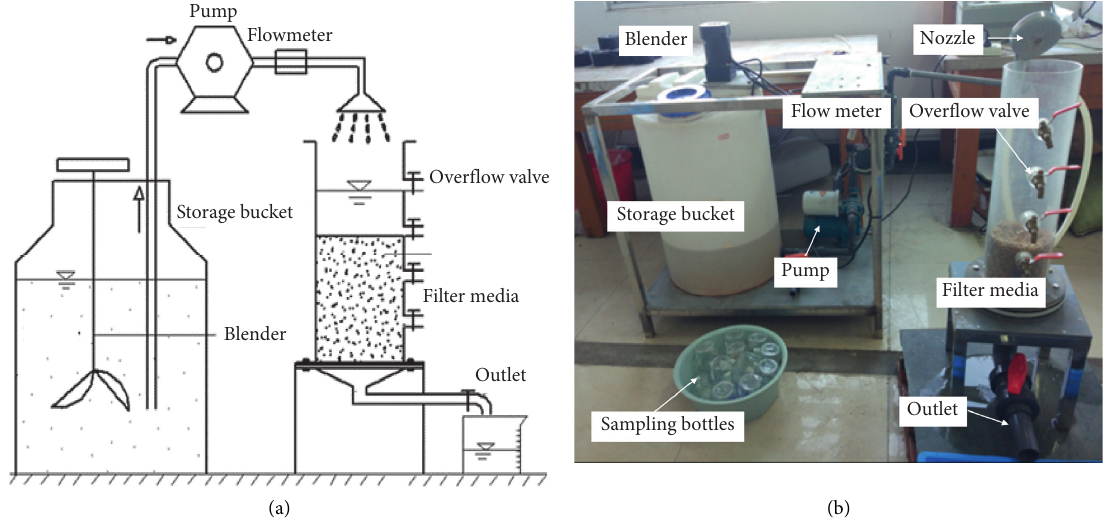
Figure 4: Schematic of filtration test equipment. (a) Diagram of the equipment. (b) Picture